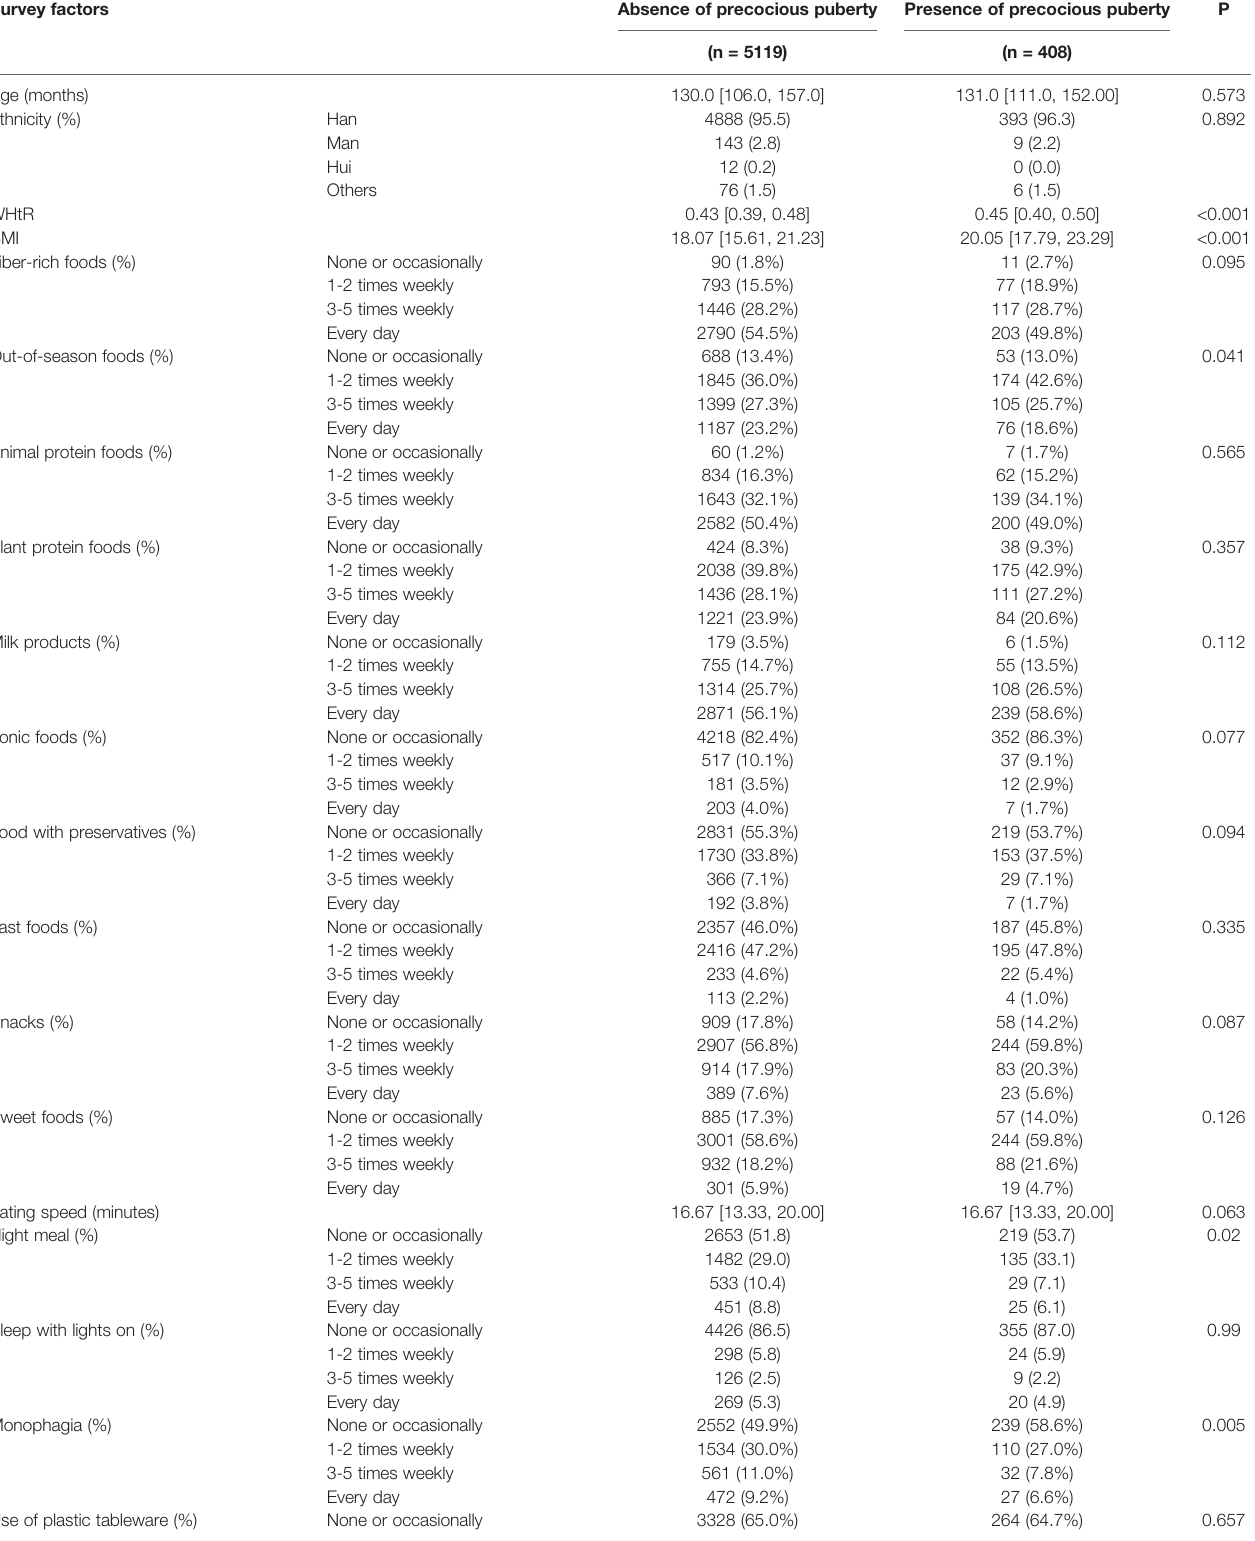
TABLE 1 | The baseline characteristics of school girls strati fi ed by the presence of precocious puberty. Survey